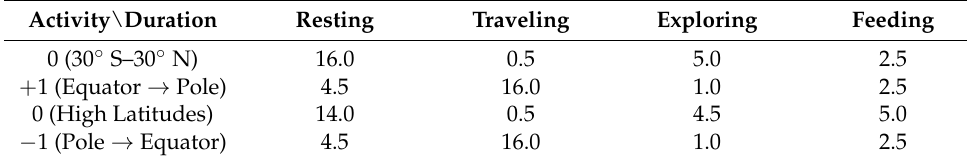
Table 3. Table of the cumulative daily behavior durations, T b , hours. Activity \ Duration Resting Traveling Exploring